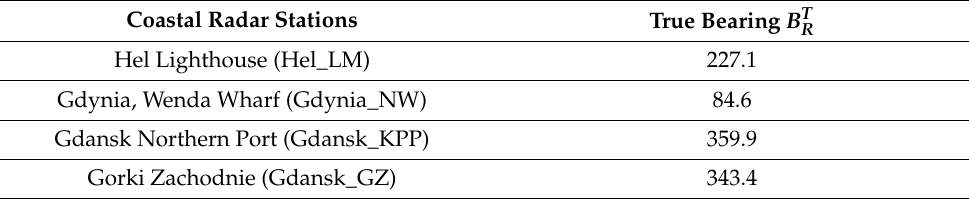
Table 3. Measured bearing from coastal radar stations to the